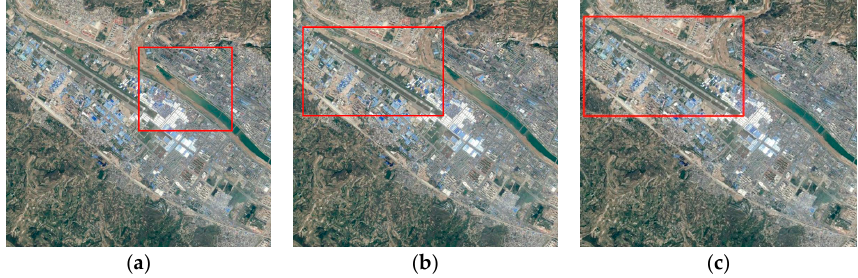
Figure 6. True detection results of different methods. ( a ) Faster R-CNN; ( b ) proposed method; ( c ) LSD + AlexNet. [Image courtesy of Google Earth].